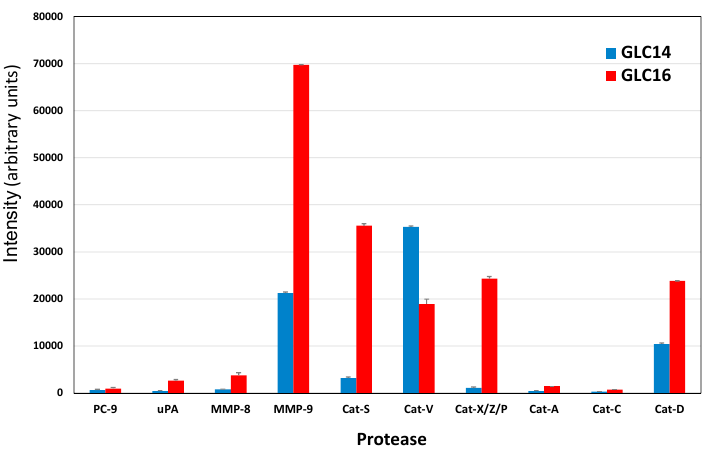
Figure 1. Selected proteases expressed by GLC14 and GLC16 small cell lung cancer (SCLC) cell lines, established from the same patient before therapy and following relapse, respectively. Values represent mean ± SD (arbitrary intensity units) and all differences are statistically significant, except for PC-9 and Cat-C.